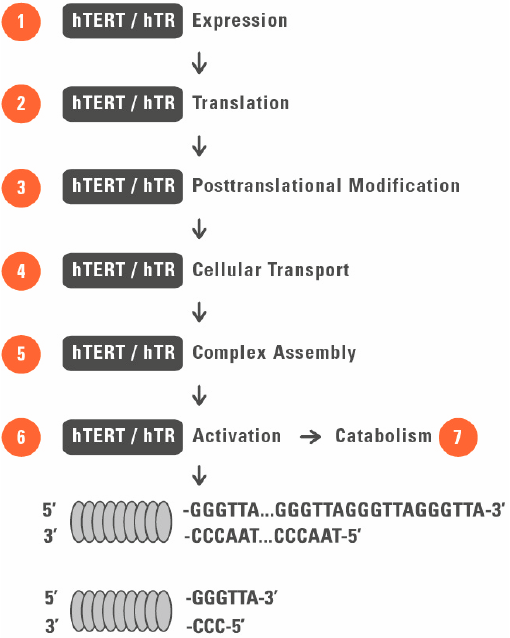
Figure 2. Therapeutic targeting of telomerase. Potential targets of telomerase for antitumor (telomerase suppressing) and rejuvenation (telomerase activation) drugs are shown by numbers 1–7. 1, inhibition/activation of gene transcription; 2, inhibition/activation of protein